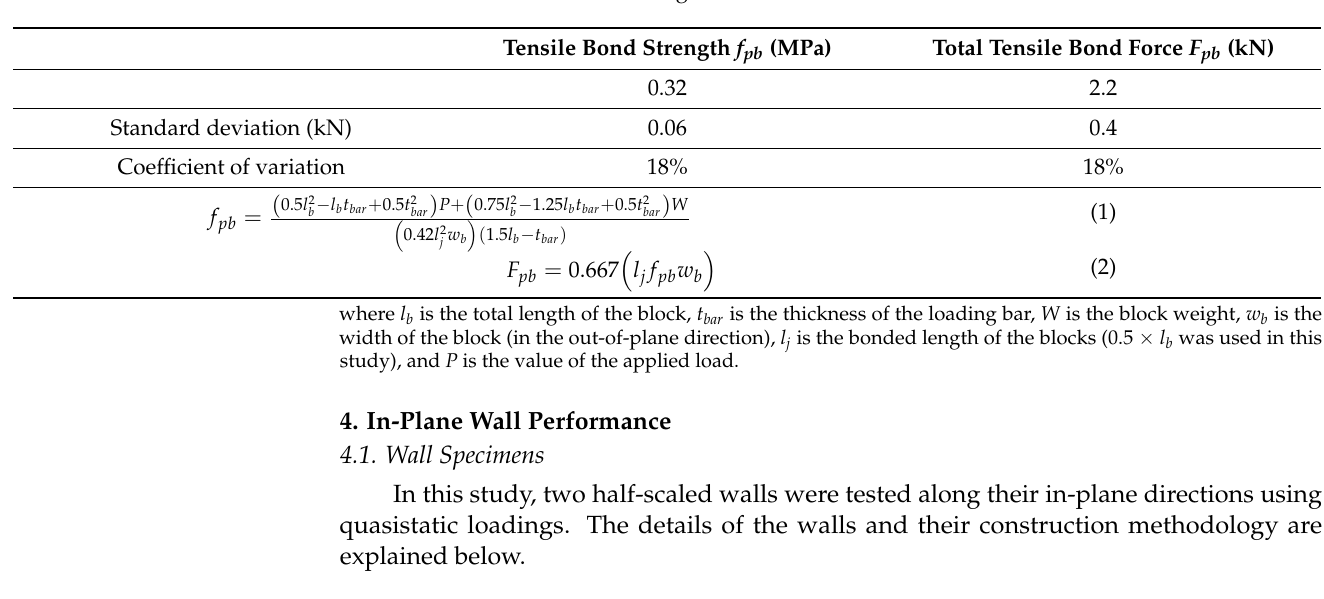
Table 4. Mortar tensile bond strength test results.